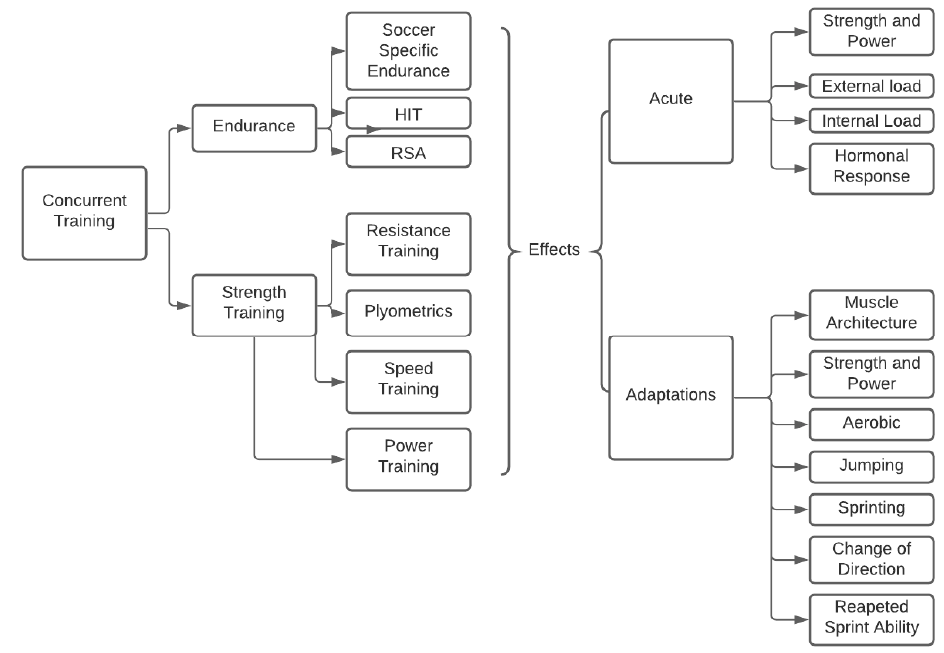
Figure 2. Concept